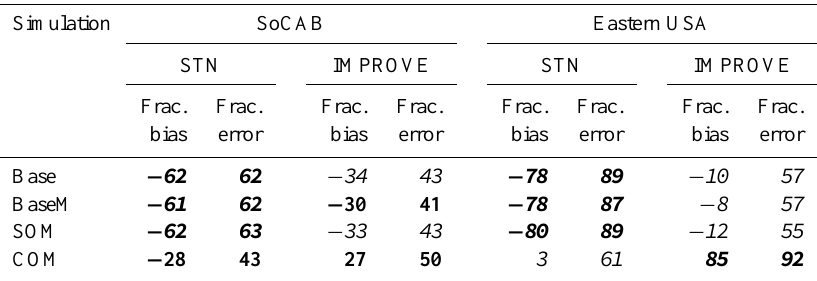
Table 2. Fractional bias and fractional error at STN and IMPROVE sites for the SoCAB and the eastern USA for the Base, BaseM (average of low- and high-yield), COM and SOM (average of low- and high-yield) simulations. Bold, italics, and bold-italics represent good , average and poor model performance (Boylan and Russell, 2006). Simulation SoCAB Eastern USA STN IMPROVE STN IMPROVE Frac. Frac. Frac. Frac. Frac. Frac. Frac. Frac.